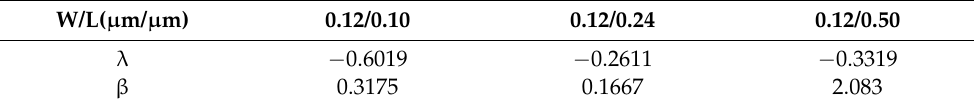
Table 3. Extracted λ and β parameters under V DS = V GS – V T = 1~1.2 V with single-fin.